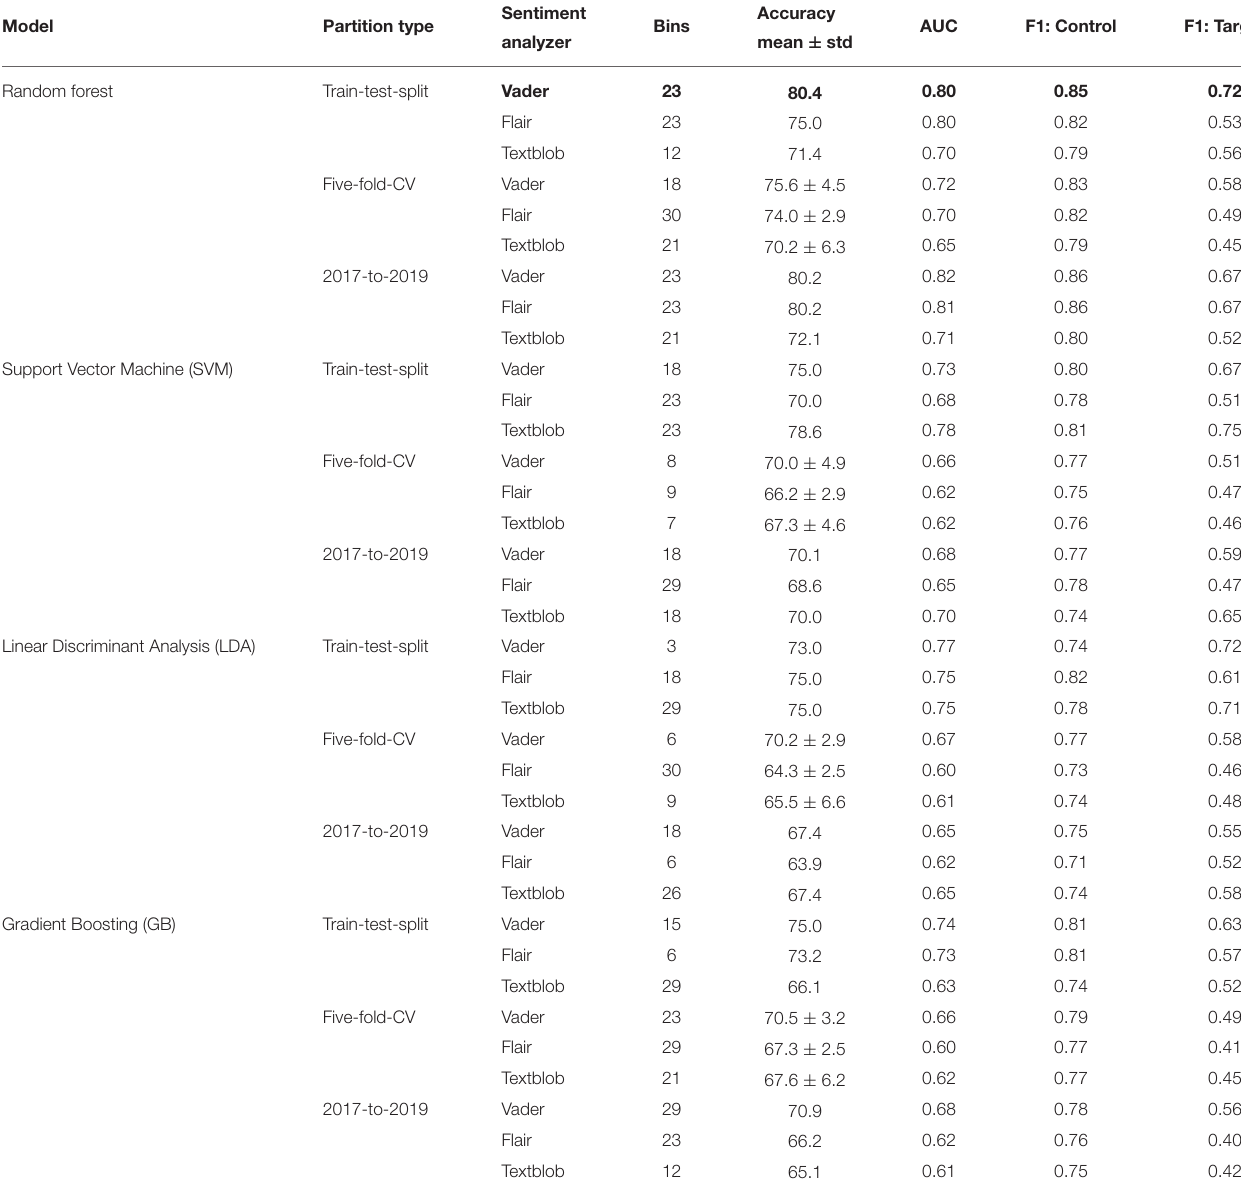
TABLE 4 | Performance of models across sentiment analyzers and partitioning schemes.